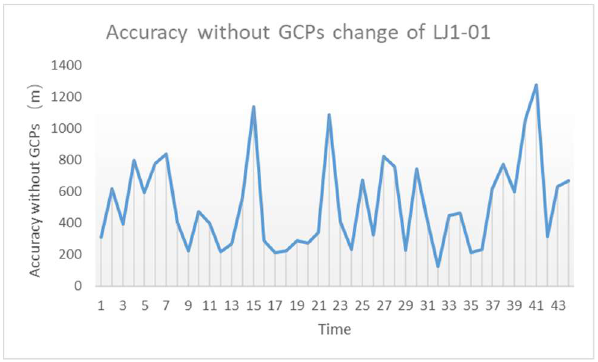
Figure 10. Examples of uncontrolled orientation accuracy assessment.